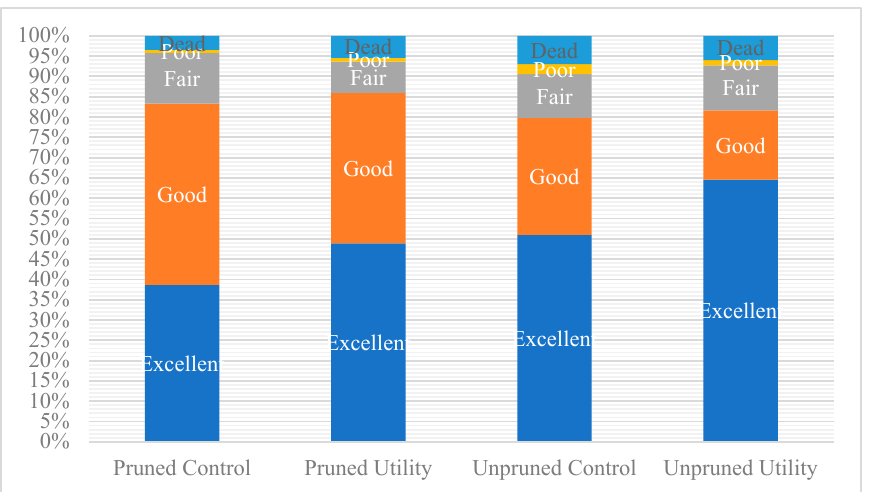
Figure 4. Distribution of tree condition for each combination of pruning status (pruned, unpruned) and plot type (control, utility); condition was based on 5% bins of percent crown dieback: “Excellent” was 0% dieback, “Good” was dieback of 5% or 10%, “Fair” was dieback between 15% and 55%, “Poor” was dieback between 60% and 95%, “Dead” was 100% dieback.